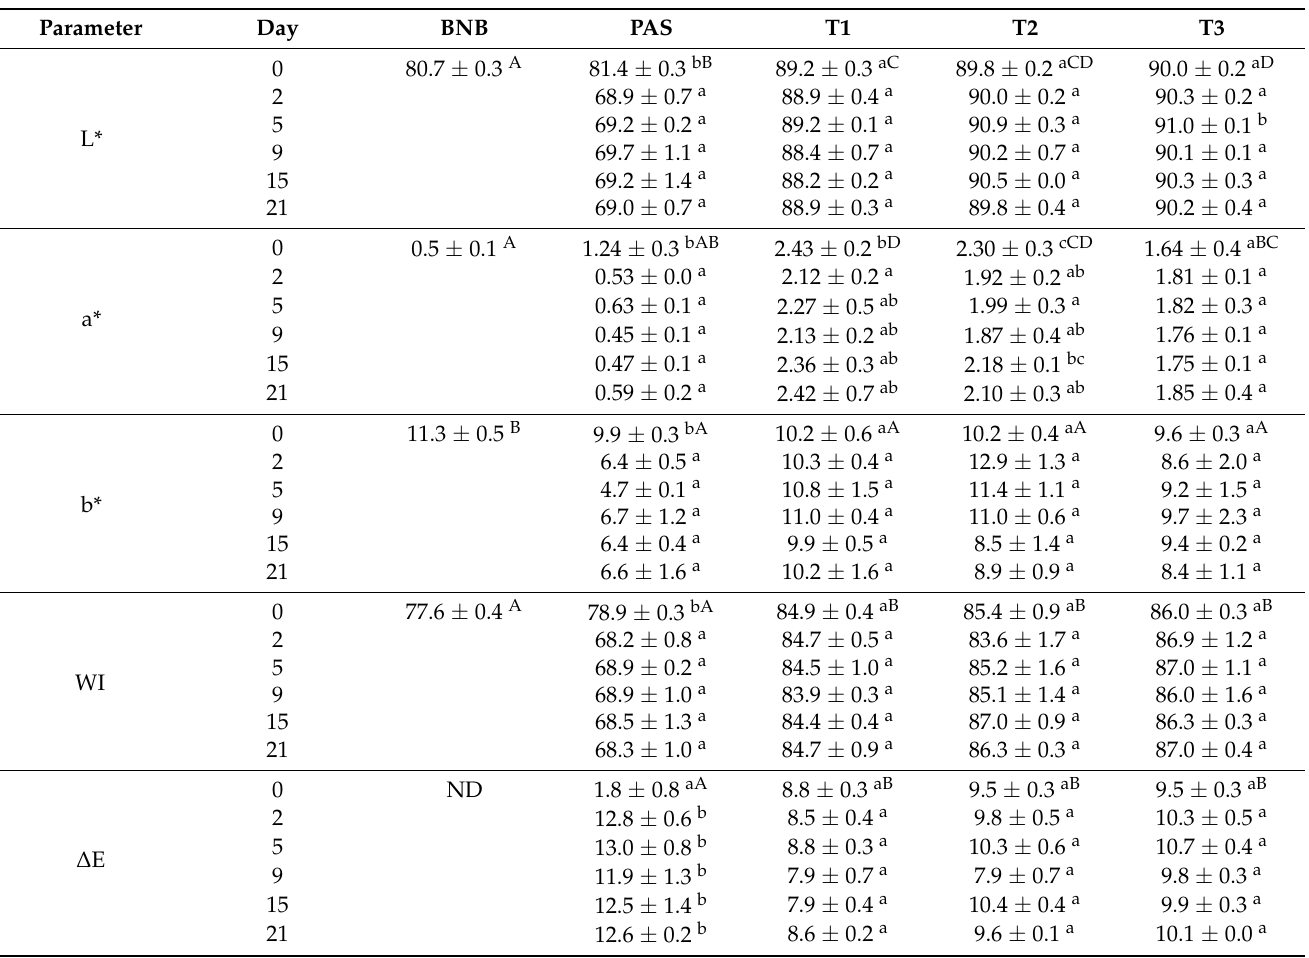
Table 3. Color properties of the BNB treated with HPH and pasteurization conserved at 5 ◦ C for 21